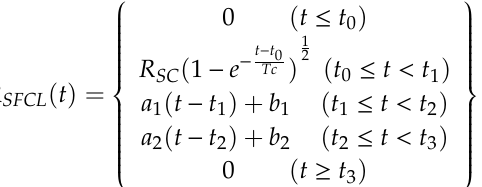
Figure 4. Case 2: Protection scheme composed of HB-MMC, SI-SFCL and HCB.